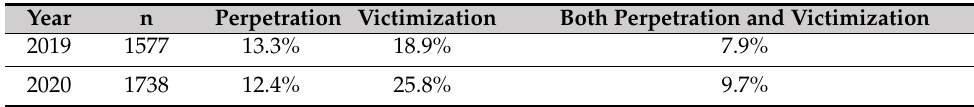
Table 3. Changes in cyberbullying experiences from 2019 to 2020.